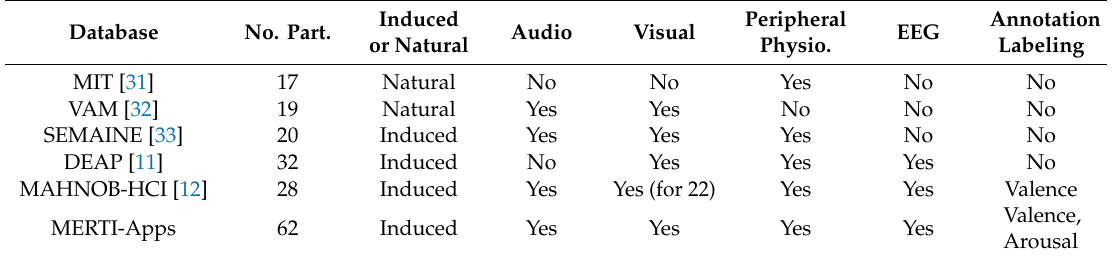
Table 1. Comparison of the physiological datasets for emotion recognition.